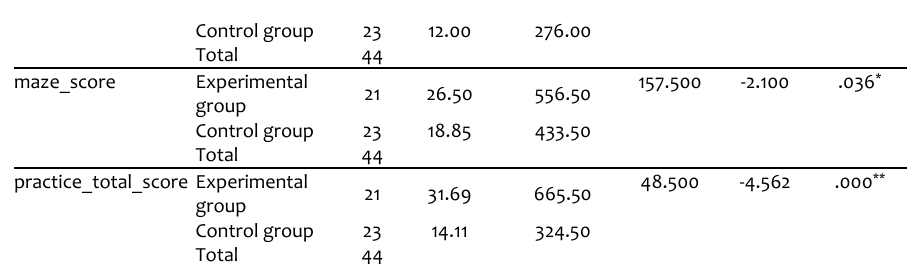
Mean Sum of Rank Ranks